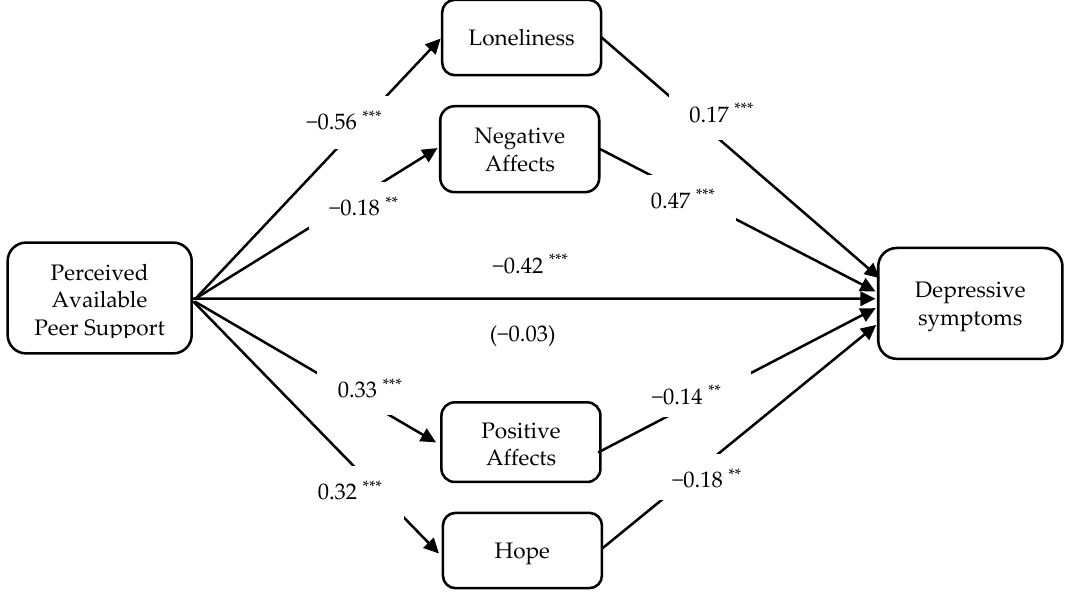
Figure 1. The direct effect (standardized coefficients) of each path. Note: ** p < 0.01, and *** p < 0.001.